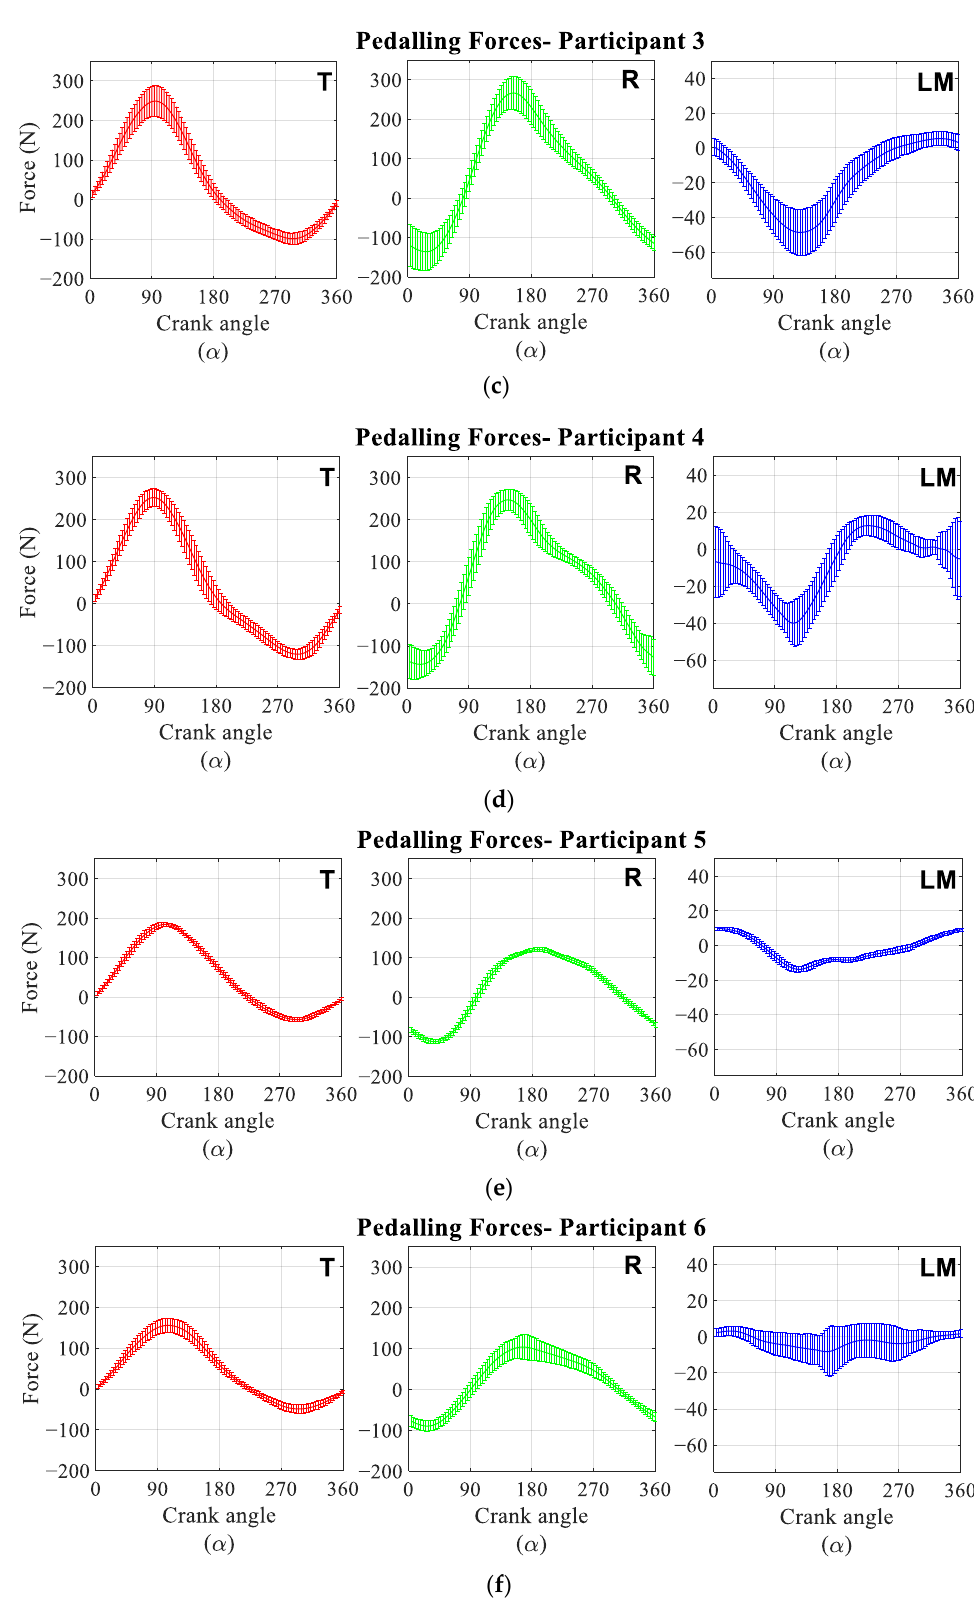
Figure 12. Mean pedalling forces time evolution applied to the pedal for each participant. Red: Tangential force (T). Green: Radial force (R). Blue: Lateral-Medial force (LM). ( a ) Participant 1. ( b ) Par-